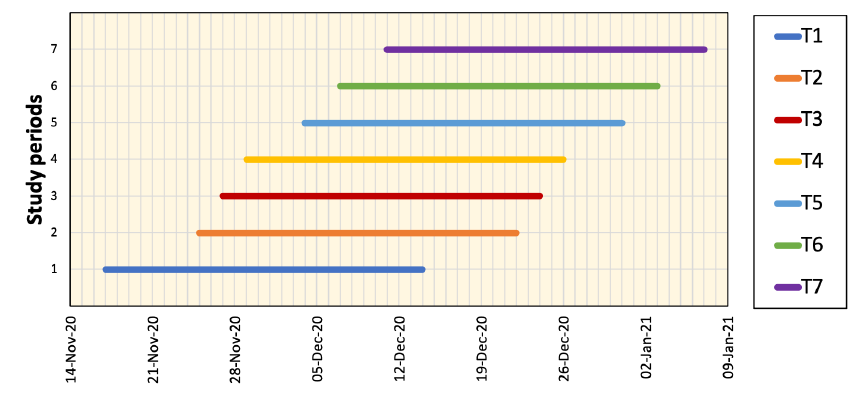
Figure 5. Different periods of prediction data (each of 28 days) investigated in this study. The prefectures of Tokyo, Aichi, Osaka, Hyogo, Kyoto, and Fukuoka in Japan were con- sidered in this study. The prediction results for these regions are shown in Figures 6 and